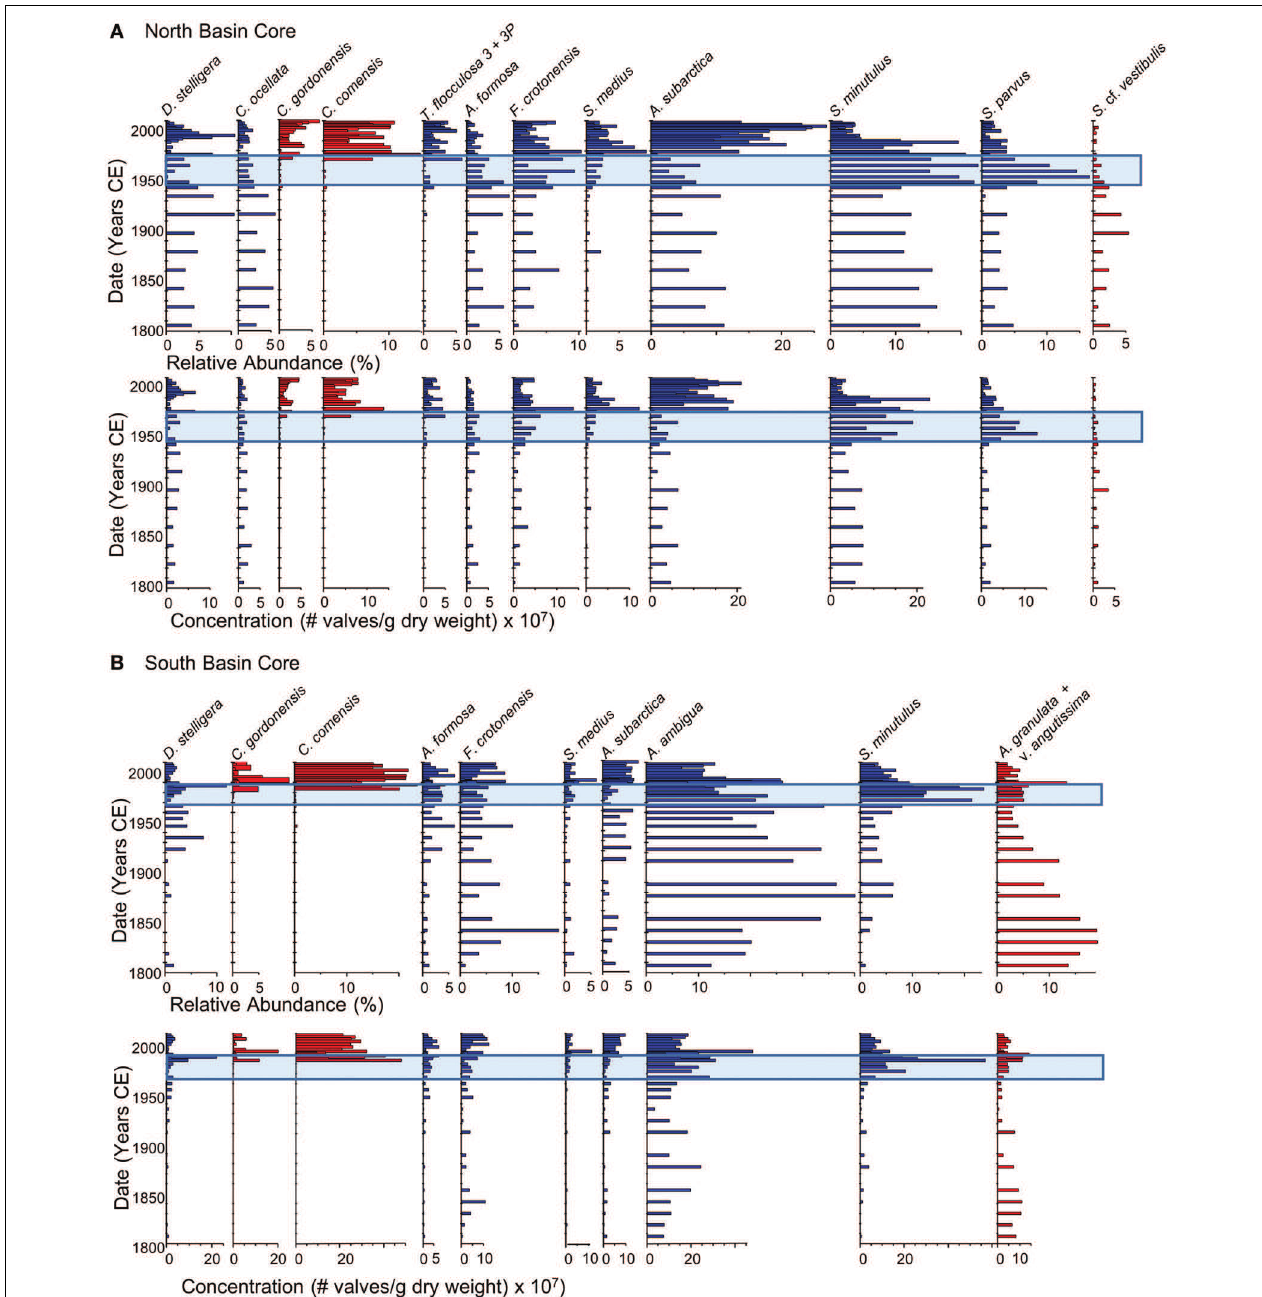
FIGURE 5 | Summary of the changes in the relative abundance and concentrations of the dominant planktonic diatom taxa ( > 5% relative abundance) over the last 200 years in dated sediment cores from the north (A) and south (B) basins of Osoyoos Lake. Taxa are arranged from left to right based on increasing diatom-inferred total phosphorus optima